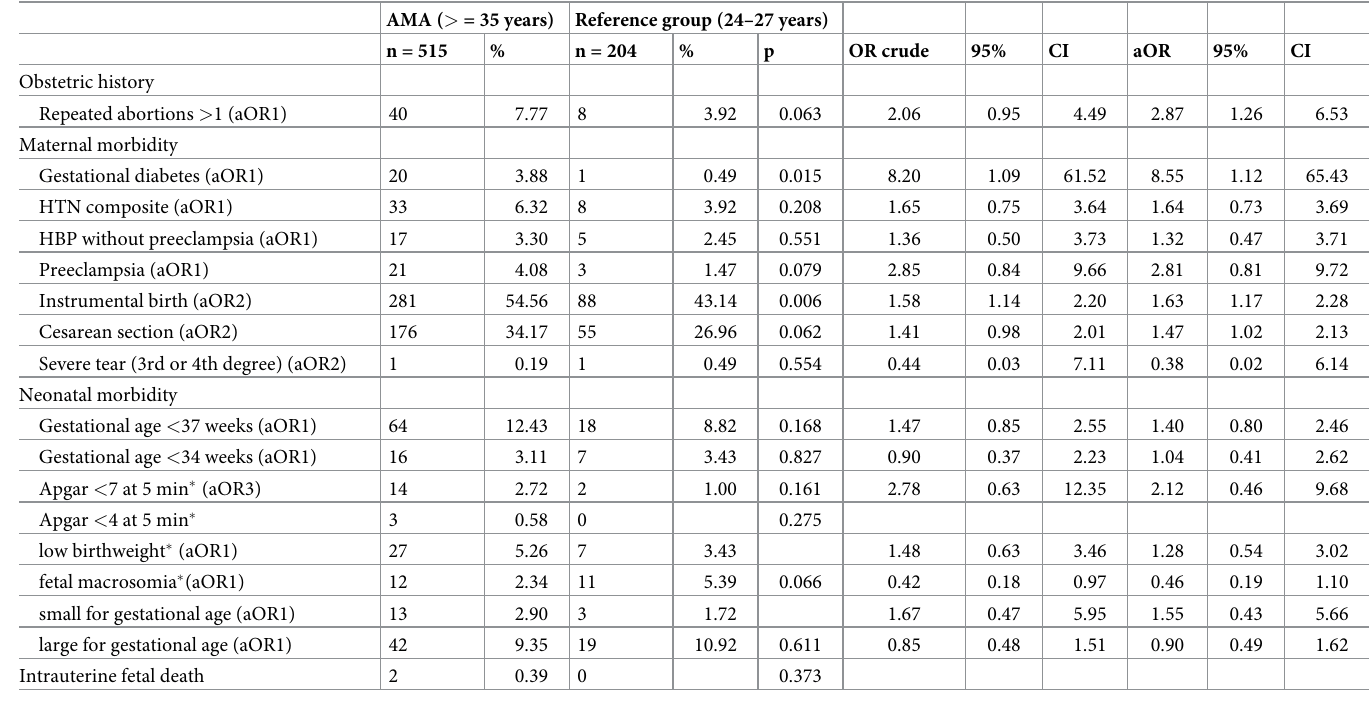
Table 3. Associations between AMA and obstetric history, maternal and neonatal morbidity and intrauterine fetal death; after restricting to primiparous women. AMA ( > = 35 years) Reference group (24–27 years) n = 515